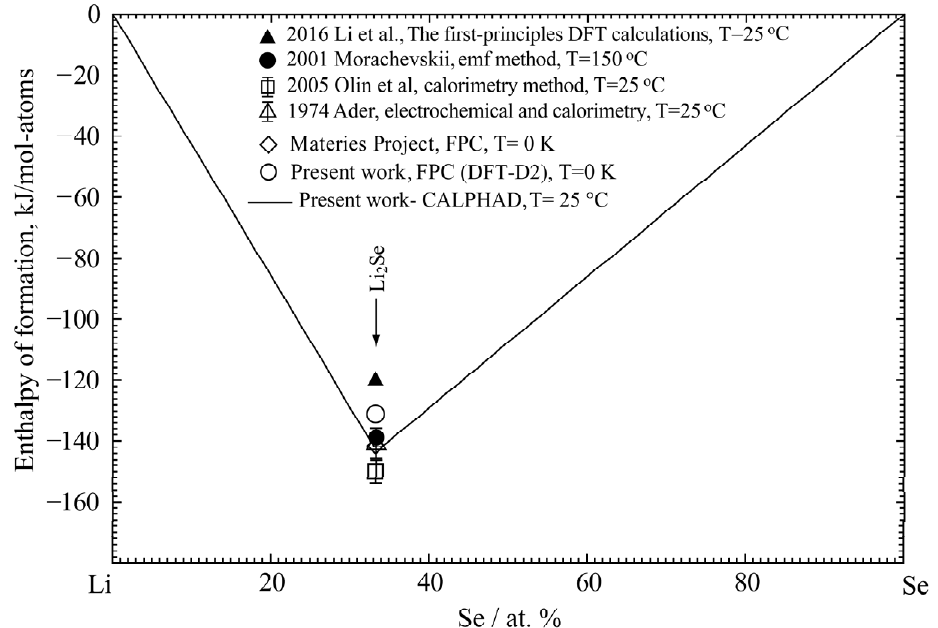
Figure 1. The calculated enthalpy of formation of the Li - Se binary system at 25 °C compared with the previously reported data [32,35,37,38] and the present results.